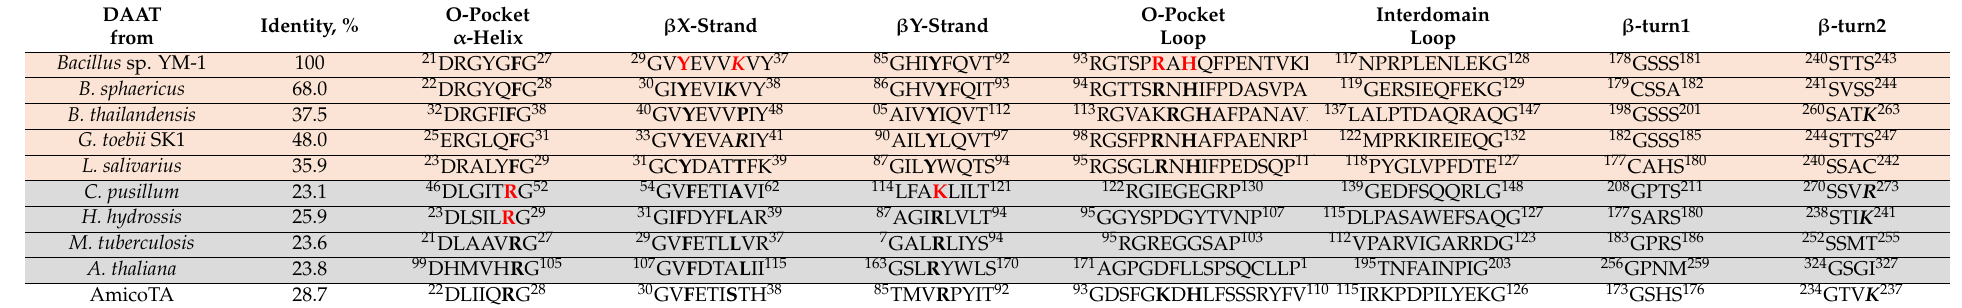
Table 1. Structure-based sequence alignment of AmicoTA and known DAATs. Amino acid composition of SSE forming the active sites of DAATs. Crystal structures of the following DAATs were analyzed: DAAT from Bacillus sp. YM-1(PDB ID 1DAA), B. thailandensis (4TM5), C. pusillum (5K3W), H. hydrossis (7P7X), and M. tuberculosis (6Q1R). AlphaFold models (accessed on 21 February 2023) [35,36] of the following DAATs were analyzed: DAAT from B. sphaericus (UniProt ID P54693), G. toebii SK1 (Q4JFX0), L. salivarius (Q1WRM6), and A. thaliana (Q8L493). Amino acid residues known to participate in substrate binding are shown in red. Similar residues in homologs are shown in bold. Positively charged residues in the P-pockets are shown in bold and italics . Canonical DAATs are highlighted in rose, non-canonical DAATs are shown in